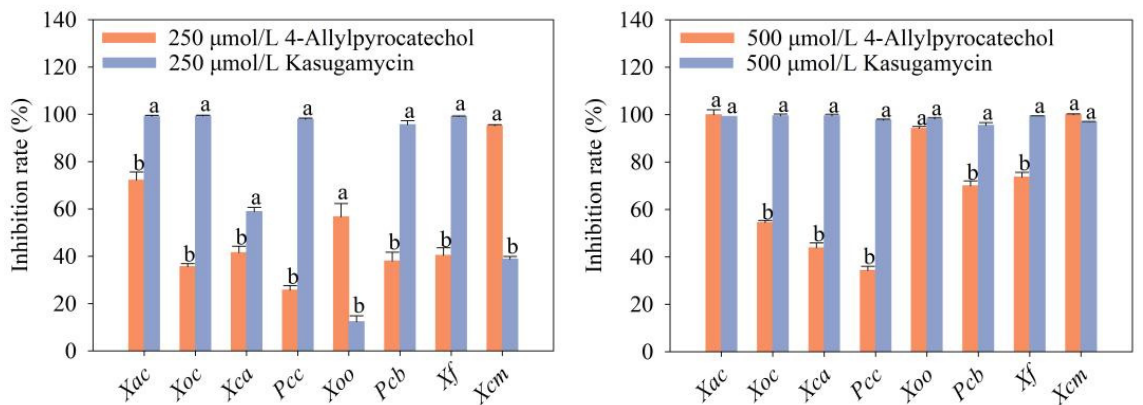
Figure 2. Antibacterial activity of 4-allylbenzene-1,2-diol against phytopathogenic bacteria. Note: Different lowercase letters in the same column show the significant difference at p < 0.05 level using Duncan’s new multiple range test. Xac represents Xanthomonas axonopodis pv. citri , Xoc represents Xanthomonas oryzae pv. oryzicoia , Xca represents Xanthomonas campertris pv. campertris , Pcc represents Pectobacterium carotovorum subsp. carotovorum , Xoo represents Xanthomonas oryzae pv. oryzae , Pcb represents Pectobacterium carotovorum subsp. brasiliense , Xf represents Xanthomonas fragariae , Xcm represents Xanthomonas campestris pv. mangiferaeindicae .